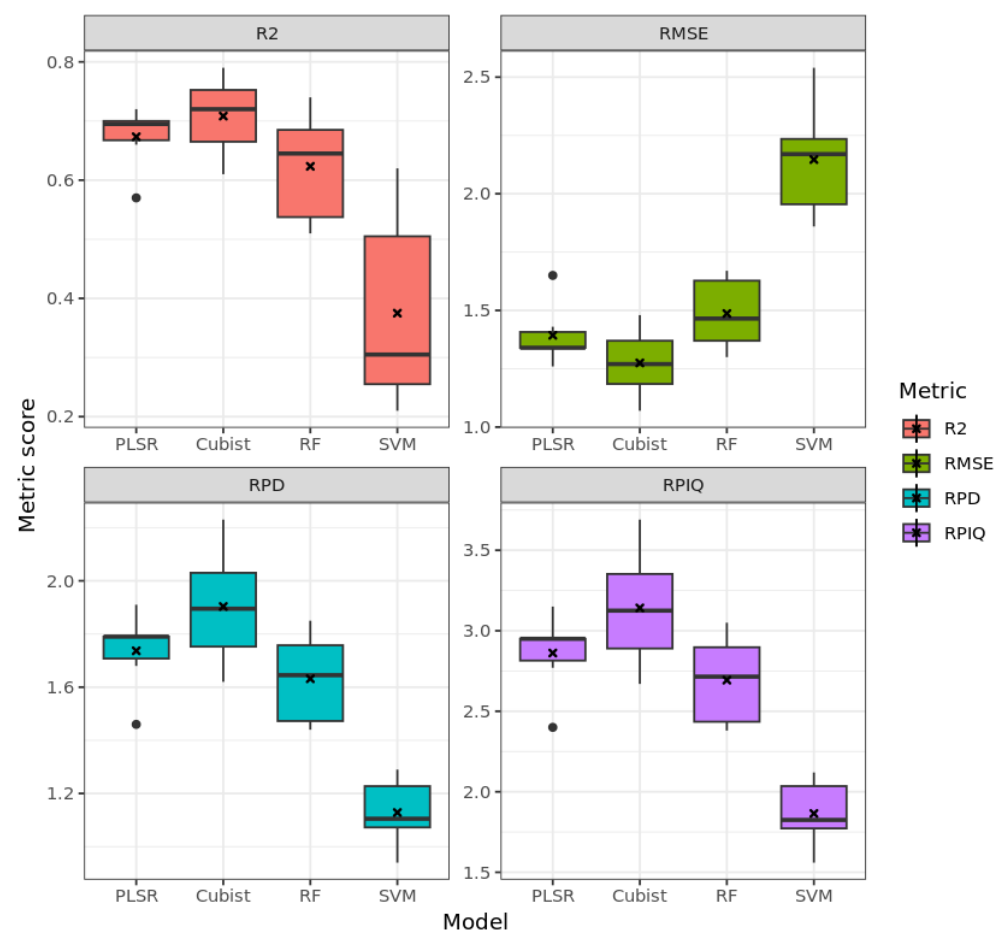
Figure 7. Box plots for the accuracy metrics for HySpex estimations of OM with the use of the PLSR, Cubist, RF, and SVM algorithms for all preprocessing methods.